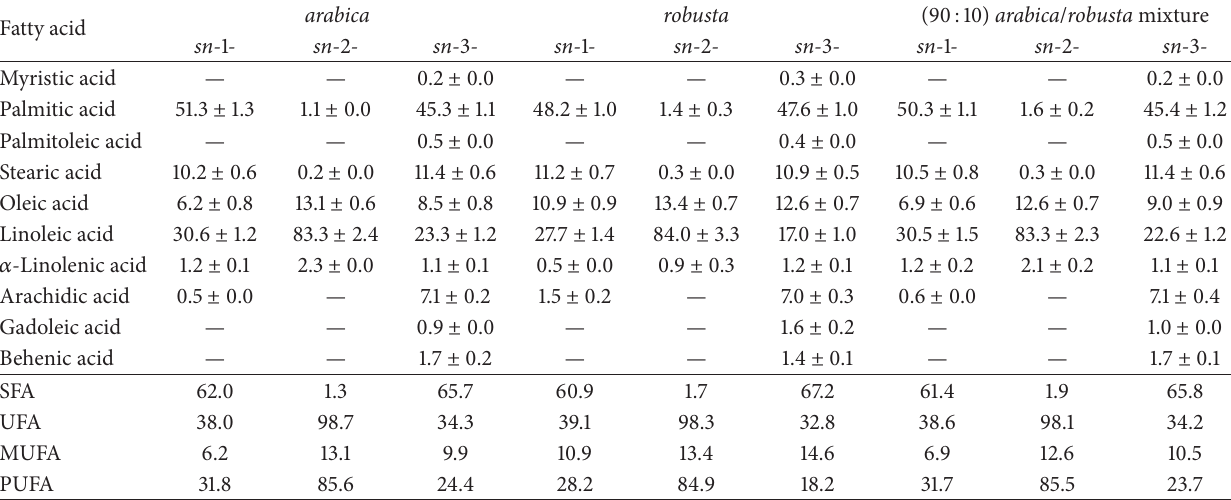
Table 2: Fatty acid intrapositional composition (% mol, mean value ± SD) of triacylglycerol fraction of arabica , robusta , and (90:10) arabica / robusta mixture roasted ground coffee.